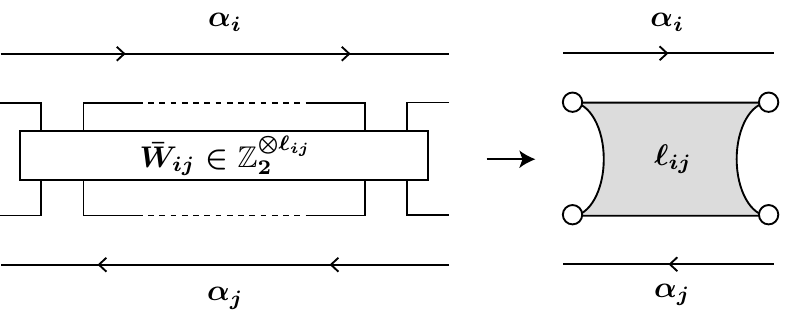
Figure 7 . Computing an open two-point function between O i and O j by taking the Wick- contractions of consecutive ‘ ij (cid:12)elds. White circles represent the color indices at the end-points. Both (cid:11) i and (cid:11) j preserve the counterclockwise